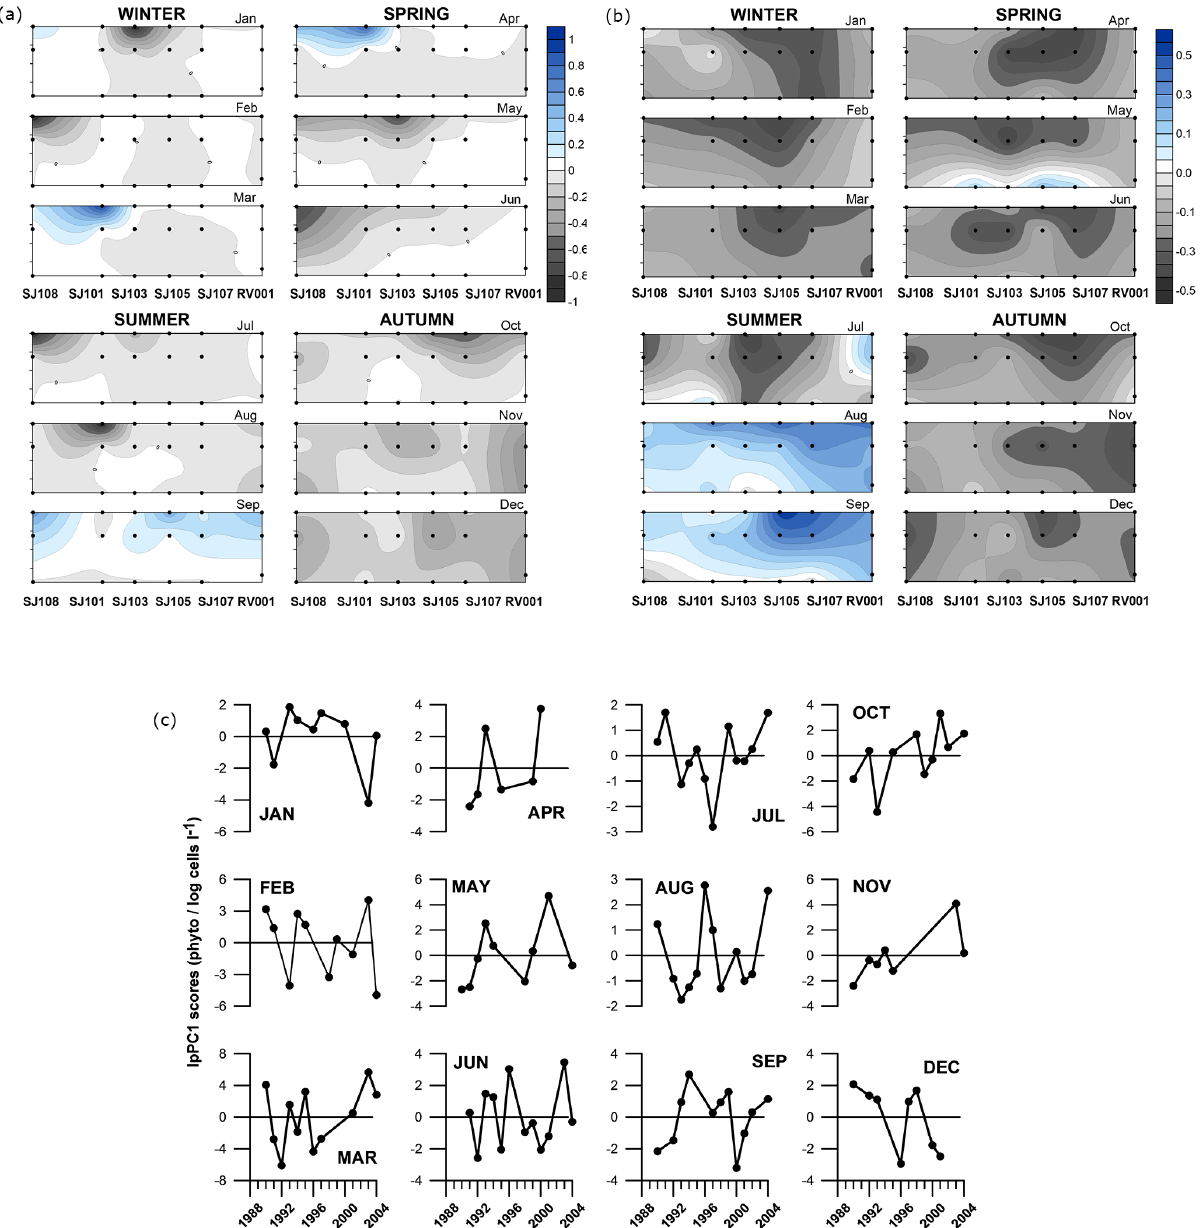
Figure 8. pPC1 loadings of original data (a) along with lpPC1 loadings (b) and lpPC1 scores (c) of log data for the phytoplankton abundance in the 1990–2004